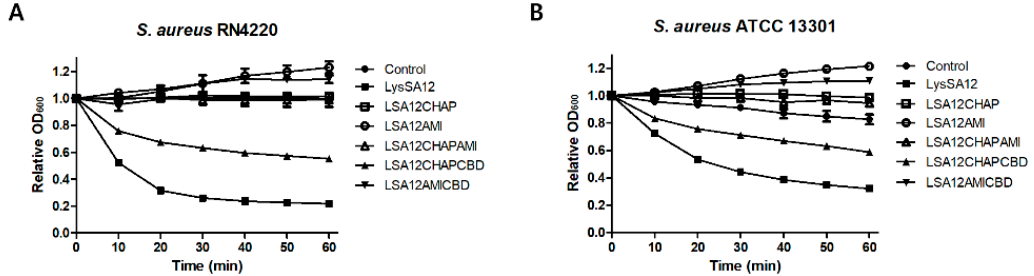
Figure 3. Activity comparison of LysSA12 and its derivate domains against S. aureus RN4220 and S. aureus 13301. Equimolar concentrations (0.3 μ M) of the purified enzymes expressed from the full length and truncated proteins were added to a 1 mL suspension of ( A ) S. aureus RN4220 and ( B ) S. aureus ATCC 13301.